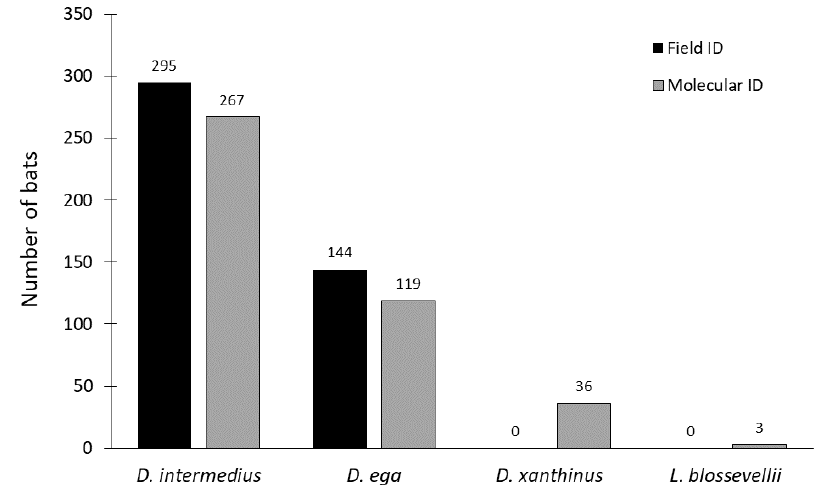
Figure 1. Number of individual bats that were identified to each species, based on either external morphology in the field or DNA barcoding.